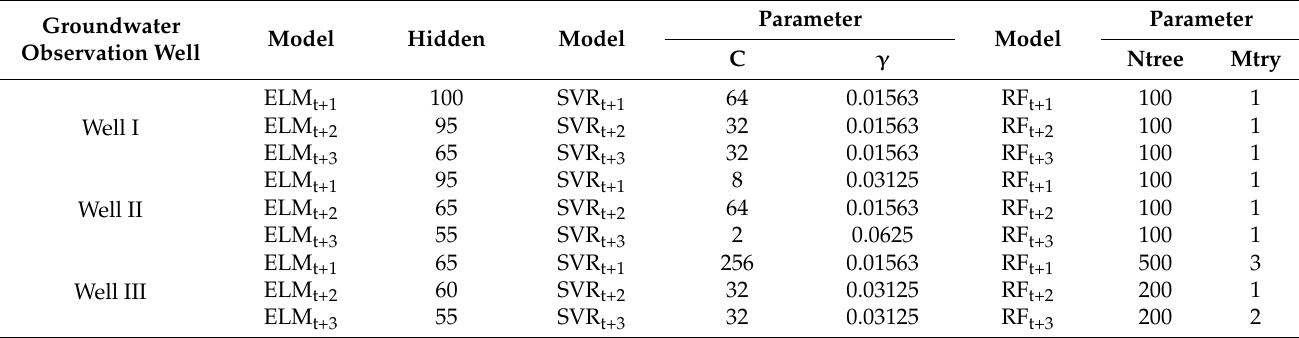
Table A1. Parameters of the ELM, SVR, and RF models for 1-, 2-, and 3-month-ahead GWL prediction for Wells I, II, and